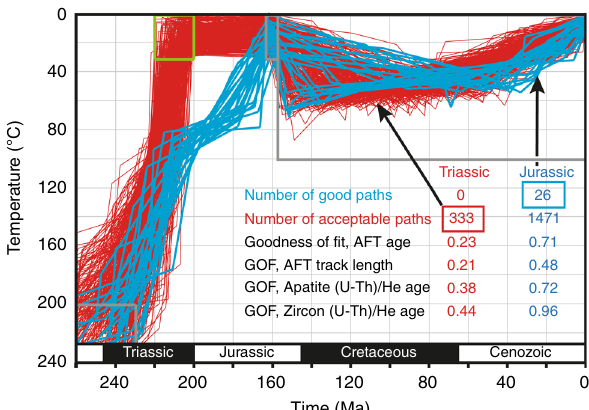
Fig. 2 Time-temperature paths. The paths are derived from AFT and apatite and zircon (U-Th)/He data (sample BG-113 in Ksienzyk et al. 4 ). Red lines are 333 acceptable- fi t paths, where the sample was forced to the surface in the Late Triassic and kept there until the Late Jurassic. Blue lines are good- fi t paths, where the sample was brought to the surface in the Late Jurassic (the 1471 acceptable paths for this model are not shown). The latter model is favored because it produces many more acceptable paths and also many good paths, while the fi rst case (red) produced no good paths. Gray boxes indicate constraints for both models, while green box applies only to Triassic surfacing (red)